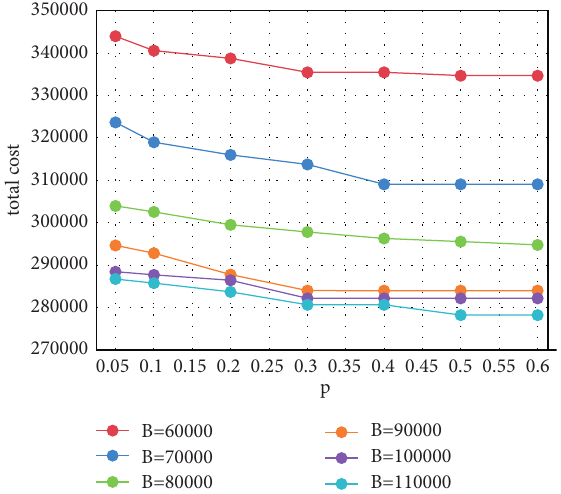
Figure 8: The changing procedure of total cost according to p and B for Model 2.